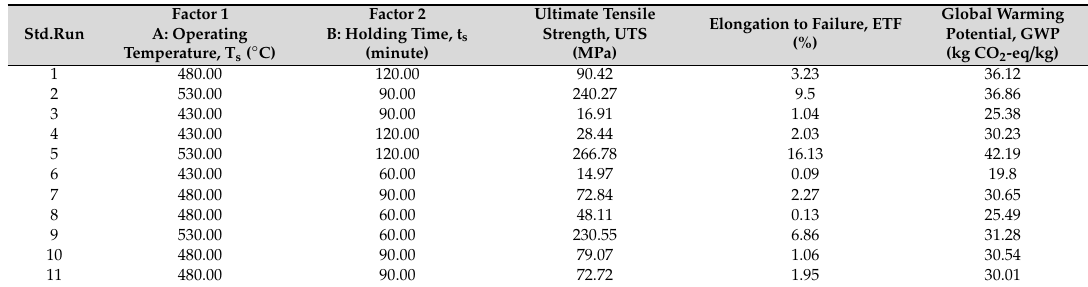
Table 6. Experimental results on UTS, ETF, and GWP.